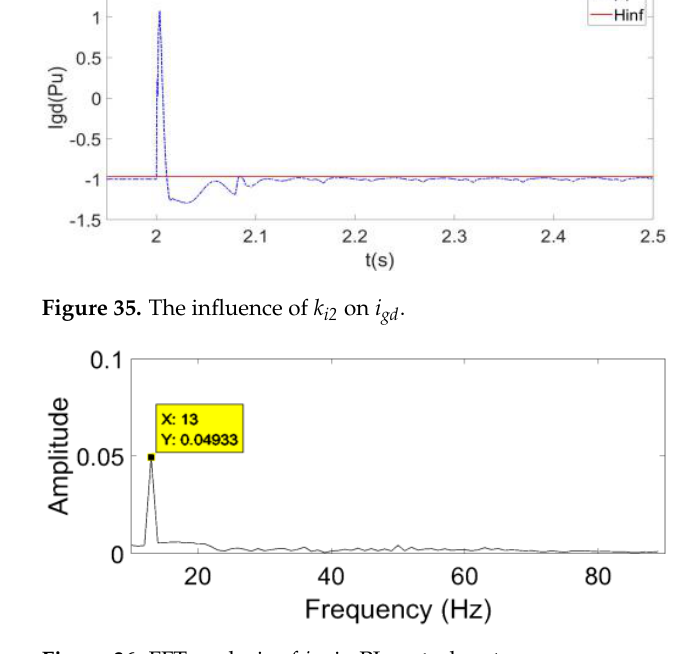
Figure 36. FFT analysis of i gd in PI control system. Figure 37. FFT analysis of i gd in the PI controller.